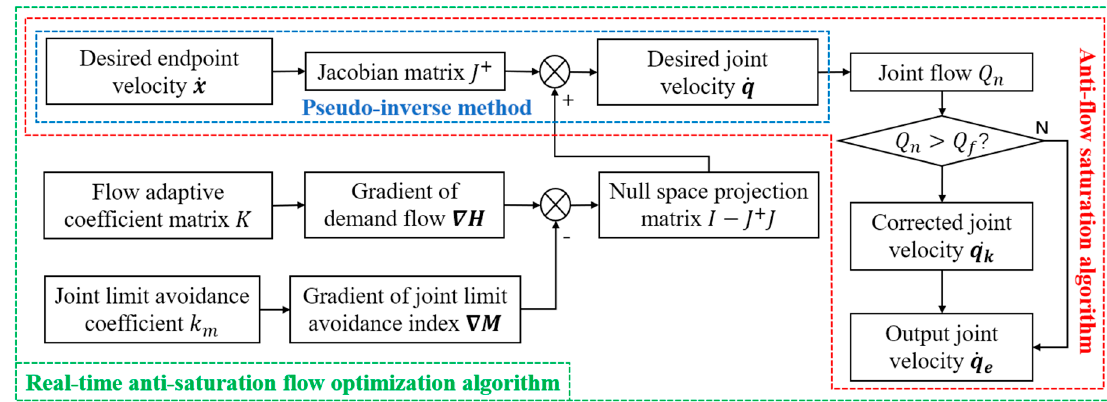
Figure 5. Block diagram of real-time anti-saturation flow optimization algorithm.